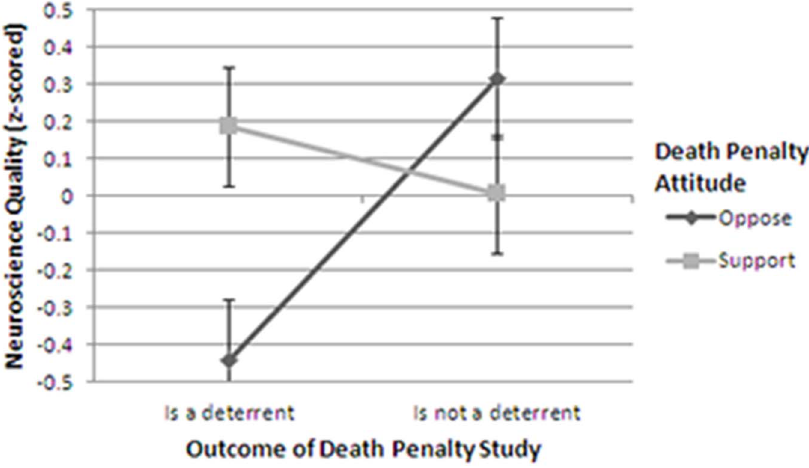
Figure 1. Perceptions of the quality of neuroscience as a function of the outcome of the study and participants’ a priori attitudes towards the death penalty. Note that error bars are + / 2 1 S.E.